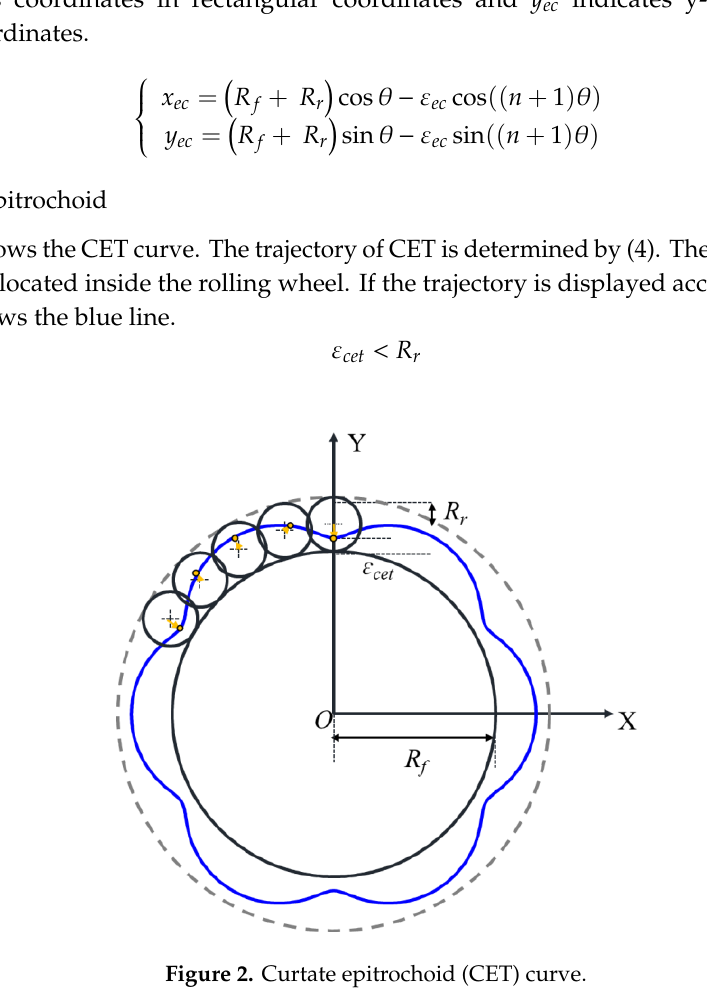
Figure 3. Prolate epitrochoid (PET) curve.